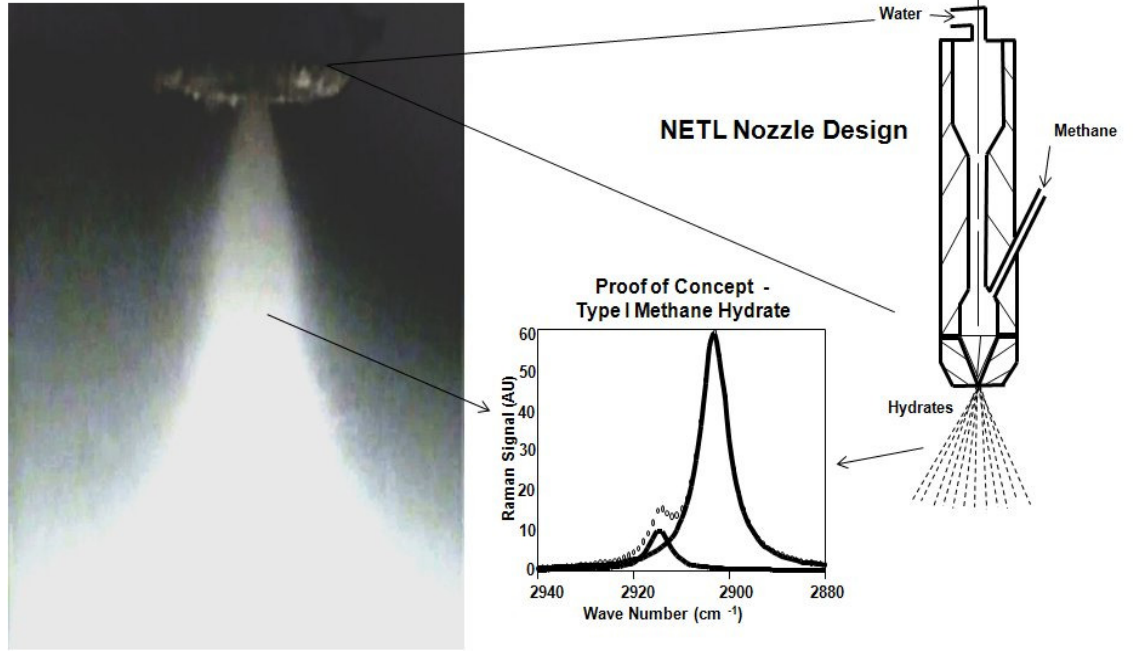
Figure 13. Typical hydrate spray and subsequent hydrate formation downstream